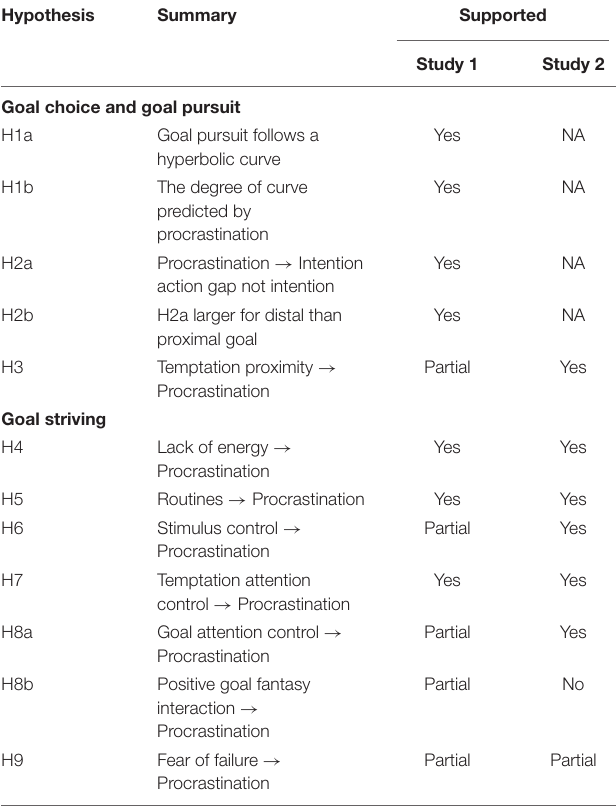
TABLE 6 | Summary of